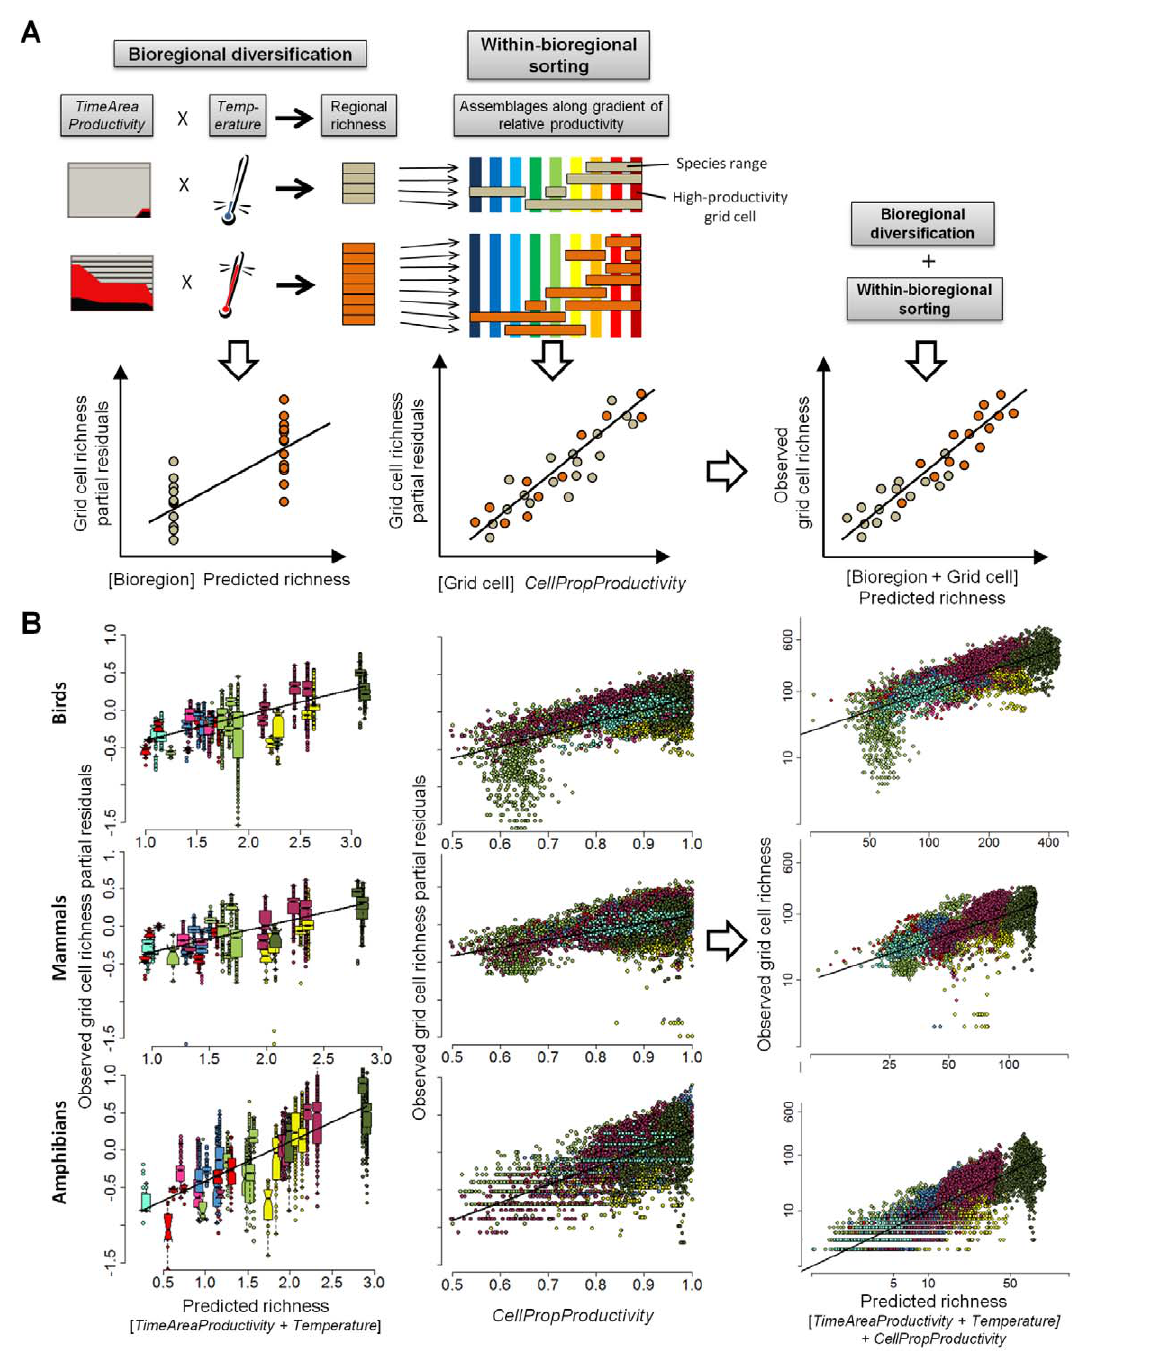
Figure 3. Hierarchical prediction of species richness at the scale of 110 km grid cells ( N =9,253). (A) Conceptual outline of the model and (B) empirical evaluation for the 110 km grid cell Total Richness of Mammals, Birds, and Amphibians. The model first fits differences in grid cell richness among bioregions based on the Resident richness model of bioregion-level diversification ( TimeAreaProductivity , Temperature , see Table 1, Figure 2; additional effect of Area was also fitted and significant for Amphibians, see Figure S4, Table S12). Second, the effect of within-bioregion gradients in productivity ( CellPropProductivity , i.e., proportion of bioregion grid cell maximum, a measure that standardizes productivity across bioregions) is fitted to predict subsequent sorting of each bioregions’ species into grid cell assemblages. The resulting hierarchical prediction of grid cell richness accounts for the scale dependence of different effects and in the case of productivity addresses the different mechanisms of the same variable at different scales. In (B), lines indicate least squares model fits ( r 2 values for observed–predicted; bioregion level, grid cell level, respectively: r 2 [Birds]=0.40, 0.61; r 2 [Mammals]=0.45, 0.58; r 2 [Amphibians]=0.59, 0.77). Boxplots (left panels) summarize points for each of the 32 bioregions. Colors indicate biome membership (see Figure 2 for legend). See also Figure S4 and Tables S12 and S13. Partial residuals illustrate the relationship between a predictor and the response given other predictors in the model.